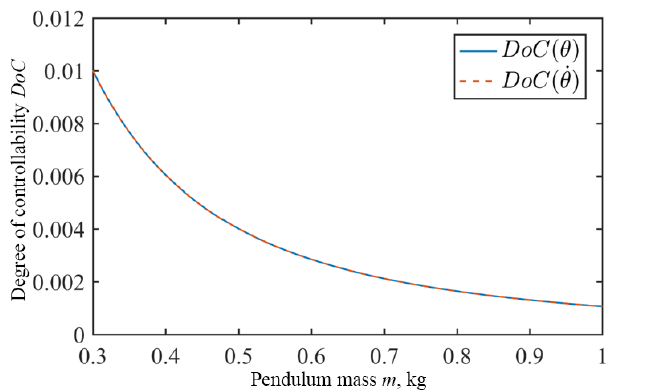
Figure 3. Change in the degree of controllability for θ , ˙ θ when increasing the mass of the pendulum m .